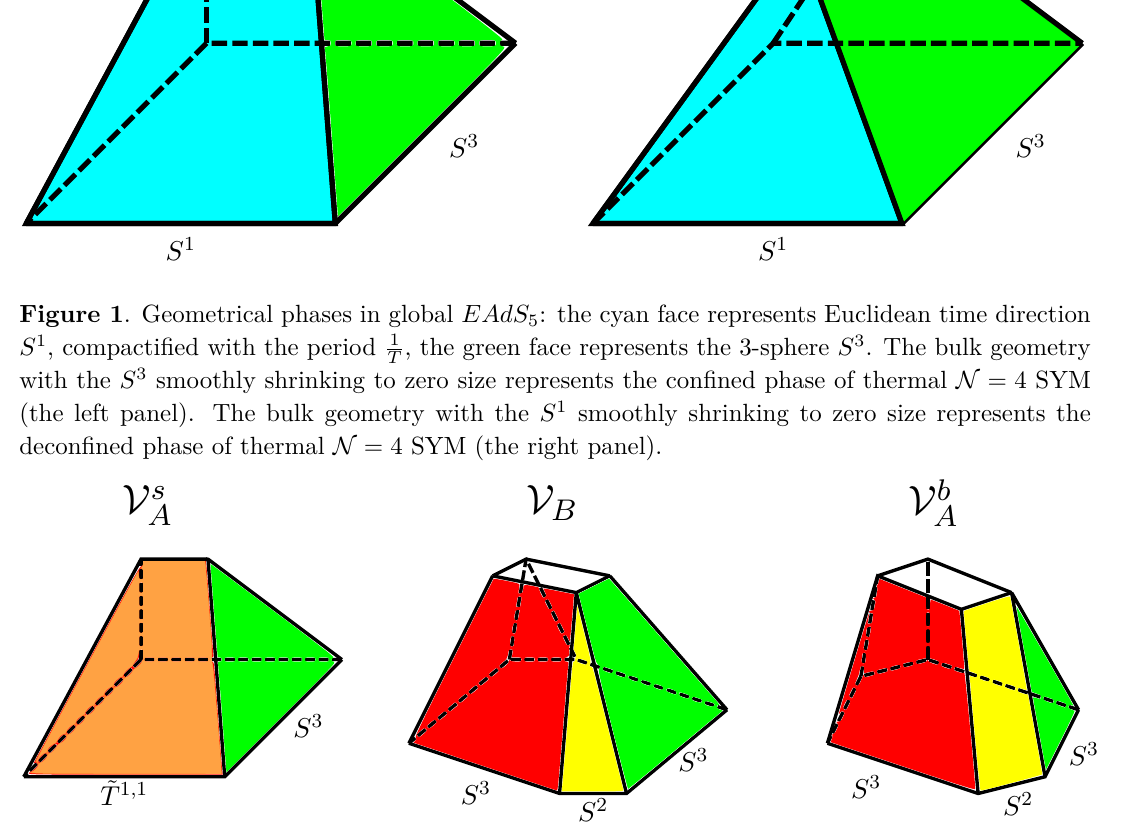
Figure 2 . Vacua of the cascading gauge theory on S 3 (the green faces) are characterized by topologically distinct gravitational backgrounds: in the left panel the boundary S 3 shrinks to zero size, with the internal ˜ T 1 , 1 (orange face) of the warped conifold having unbroken U(1) symmetry; in the middle panel the 2-cycle (the yellow faces) of the deformed conifold shrinks to zero size; in the right panel the boundary S 3 shrinks to zero size but the conifold is deformed — the U(1) symmetry of ˜ T 1 , 1 is spontaneously broken to Z 2